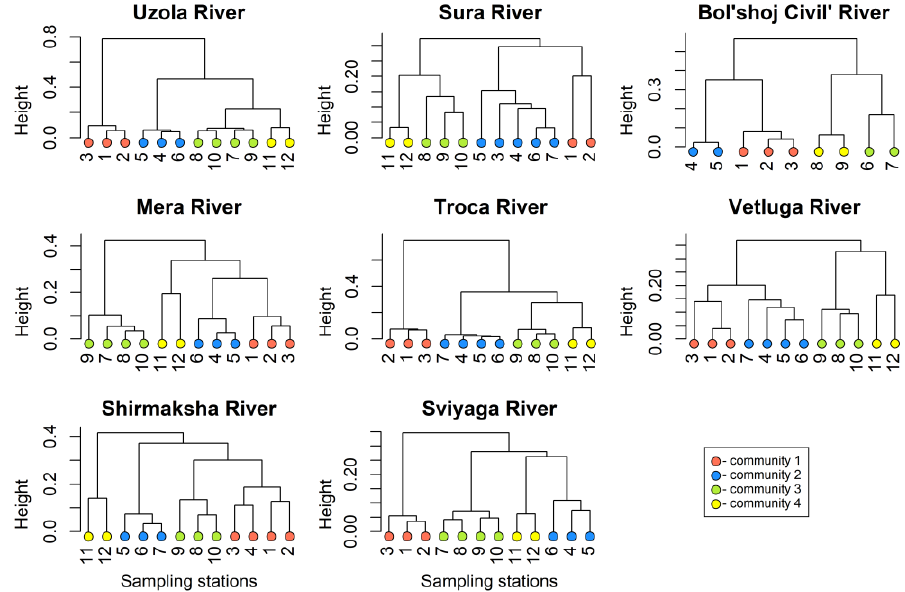
Figure 2. Hierarchical clustering dendrograms of zooplankton samples for the studied water bodies, built using the cosine of the angle between the species abundance vectors as a similarity metric. The station numbers correspond to the numbering in Figure 1.